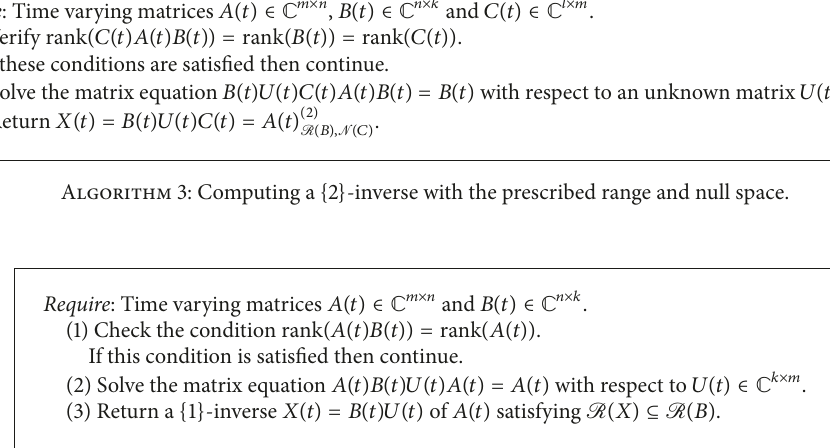
Algorithm 4: Computing a {1} -inverse 𝑋 of 𝐴 satisfying R (𝑋) ⊆ R (𝐵) .